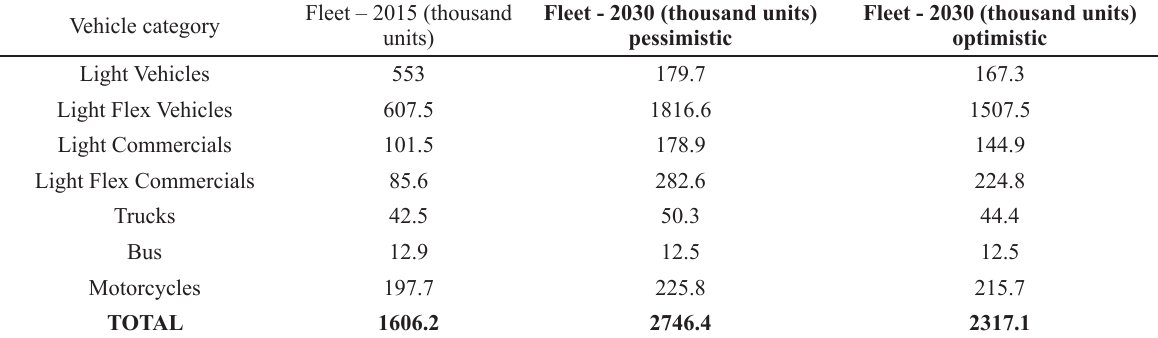
Total fleet by category for the MRPA according to the scenarios for 2015 and